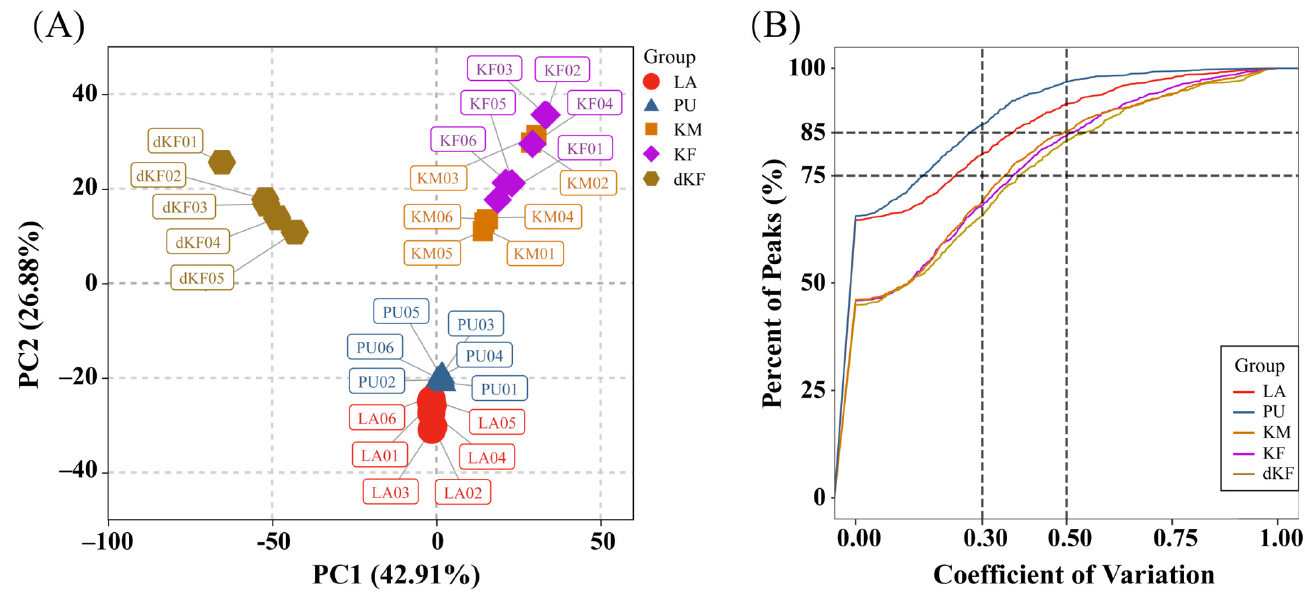
Figure 1. Principal component analysis (PCA) and coefficient of variation (CV) of untargeted metabolomic datasets. ( A ) PCA score plot. ( B ) coefficient of variation score plot. The x-axis indicates the CV value, and the y-axis again indicates the ratio of the number of metabolites that is less than the corresponding CV value to the total number of metabolites. Different stages of K. inachus are represented by different groups in different colors (larvae: LA: red; pupae: PU: blue; male adults: KM: orange; female adults: KF: purple; diapausing female adults: dKF: brown).